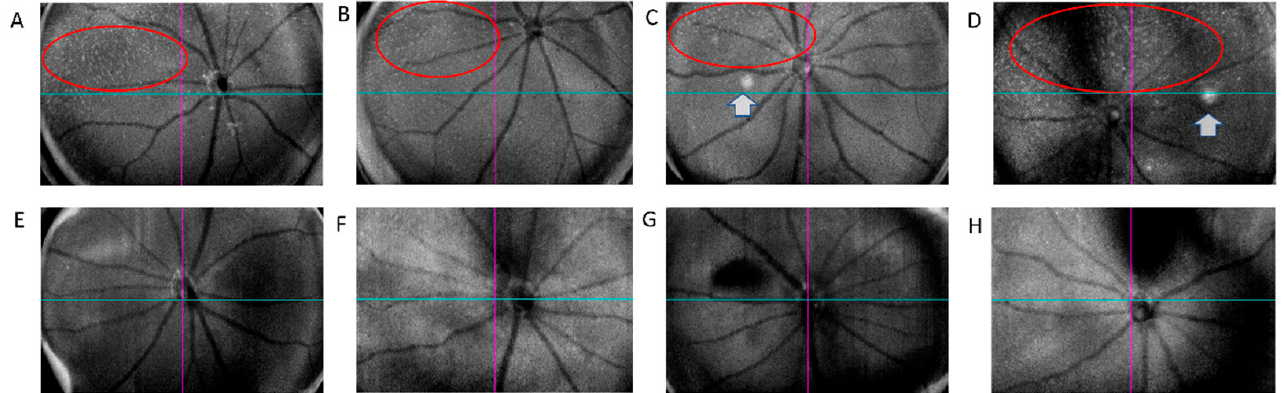
Figure 4. Representative OCT structural avascular plexus images of aged CAG-HtrA1 Tg and wild- type mice (26–29 months). Subretinal deposits (red ovals), which partially correspond to small white-yellowish retinal foci on CFP, were scattered through the avascular slab while wild-type shows minimal deposits. Arrows indicate large white lesions (type 1 lesions). Representative photographs from four mice per group are shown ( A – D ): CAG-HtrA1 Tg and ( E – H ): Wt.